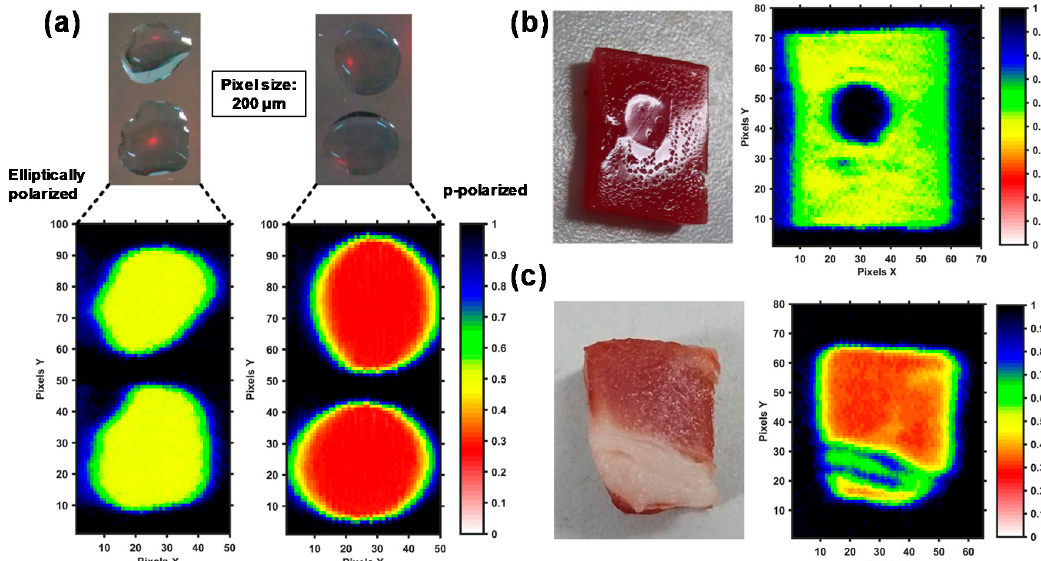
Figure 7. THz-ATR imaging of ( a ) distilled water, ( b ) a piece of blood agar, and ( c ) porcine tissue. Reproduced with permission from [33], Copyright © 2017, IOP Publishing.